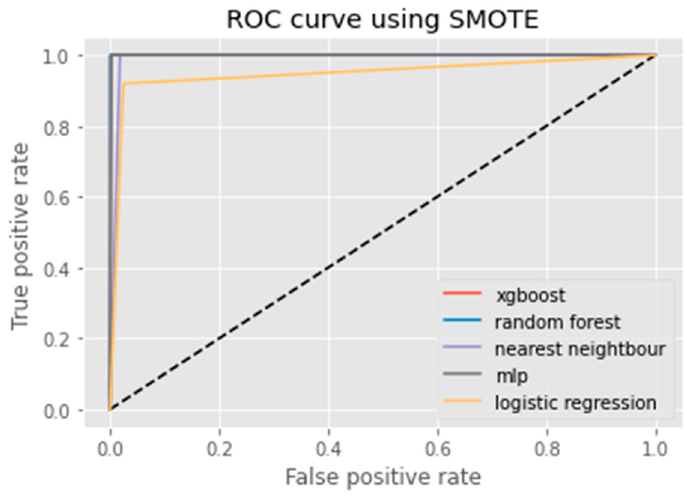
Figure 3. ROC curve of Original Dataset.